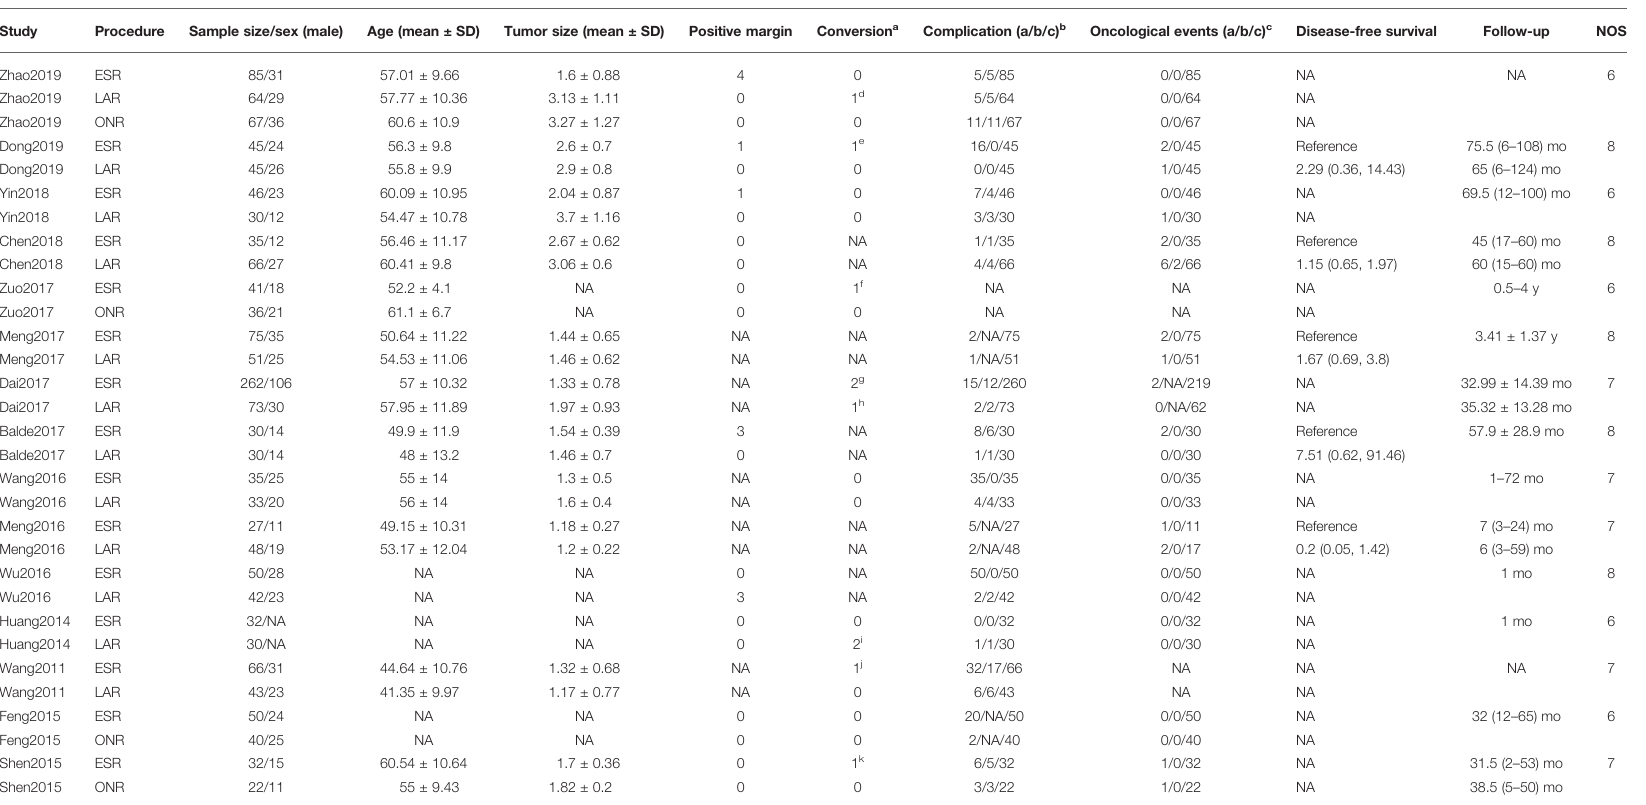
TABLE 1 | Summary of eligible